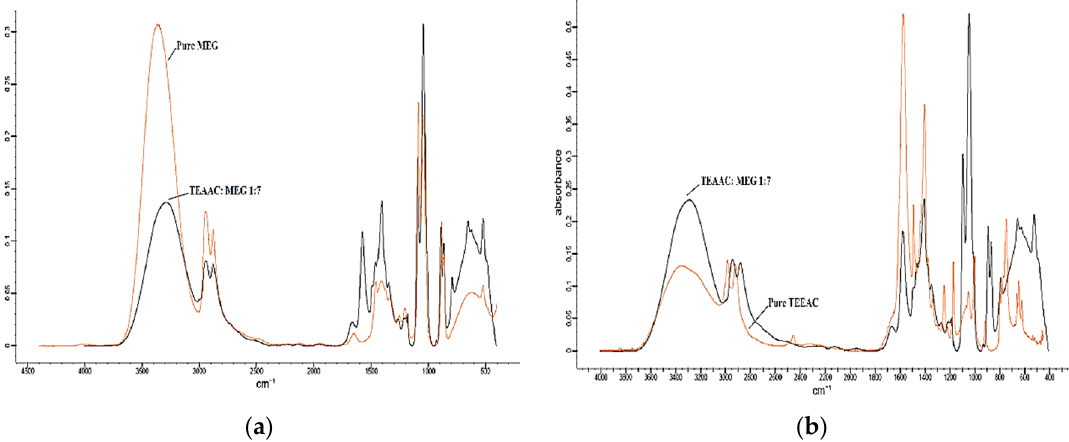
Figure 4. The FTIR comparison of TEAAC:MEG with ( a ) pure MEG and ( b ) pure TEAAC. MEG, Mono-Ethylene Glycol.